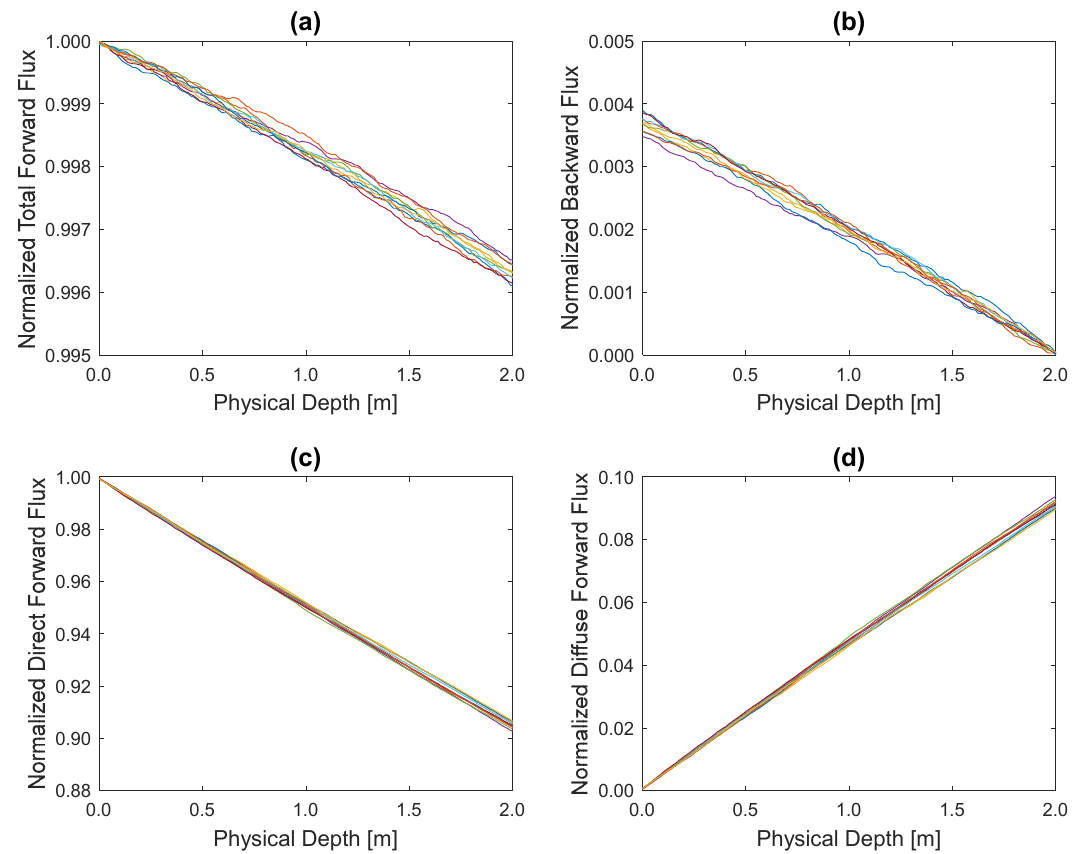
Figure 5. Depth-dependent flux curves for ten LES polydisperse spatial distributions, chosen to be very near a total optical thickness of 0.1. Spatial positions are uniformly random. Again, panels ( a )–( d ) show four flux components: total forward, backward, direct forward and diffuse forward (respectively).